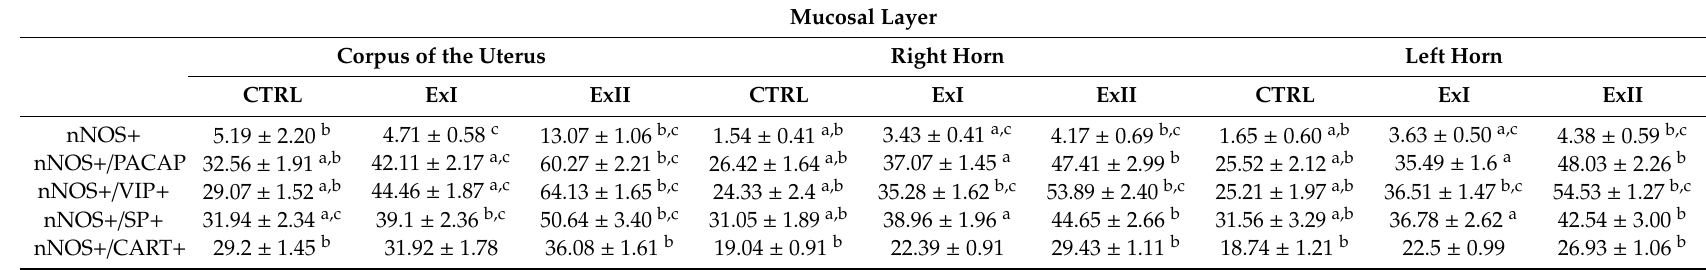
Table 2. The number of nNOS-positive fibers and their neurochemical characterization in the uterine corpus as well as in the rights and lefts horns in mucosal layer of the control animals (CTRL) and pigs treated with low (ExI) and high (ExII) dose of bisphenol A. Mucosal